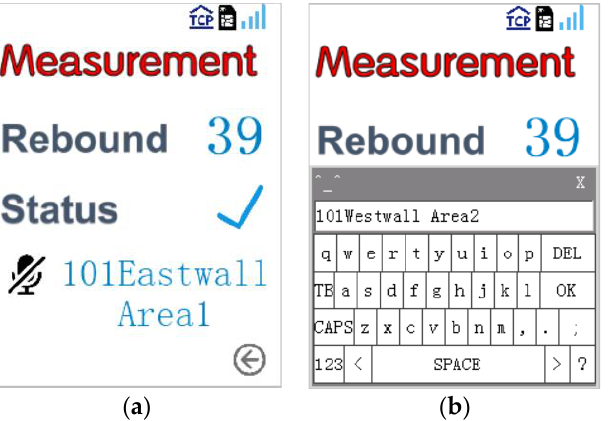
Figure 3. ( a ) The user interface screen of intelligent rebound hammer. ( b ) The screen of user interface during modification of the recognized speech text.